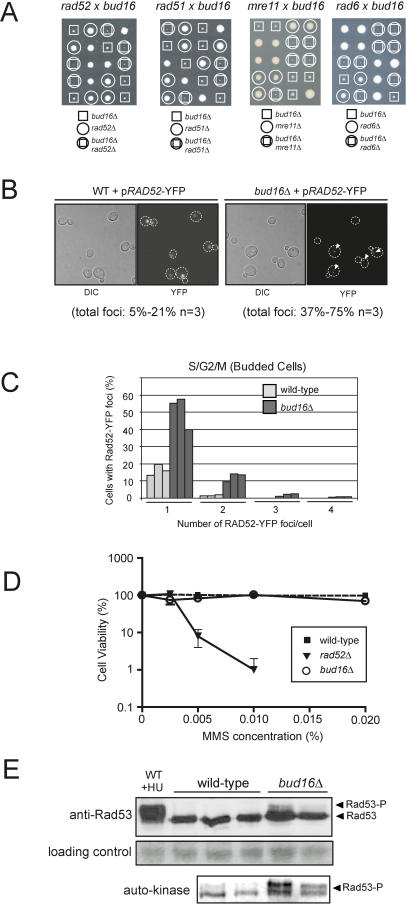
The BUD16 Gene Deletion Causes DNA Lesions and Checkpoint Activation(A) Tetrad analysis of crosses between bud16Δ and rad52Δ, rad51Δ, mre11Δ, or rad6Δ.(B) Micrographs of wild-type (WT) or bud16Δ cells expressing Rad52-YFP. Left panels: differential interference contrast (DIC). Right panels: YFP fluorescence microscopy (YFP). Arrowheads point to Rad52-YFP foci.(C) Quantitation of Rad52-YFP foci per cell. Three independent isolates were examined with over 180 cells per isolate counted.(D) Survival curves of wild-type, bud16Δ or rad52Δ cells serially diluted and plated onto rich media +/− MMS (as indicated) and grown for 3–8 d at 30 °C in triplicate. Percent survival at a given MMS concentration represents the number of colony-forming units of the indicated strain divided by the colony-forming units of the wild type plated on media lacking MMS. No viable rad52Δ colonies were recovered at concentrations above 0.015% MMS.(E) bud16Δ cells engage the DNA damage checkpoint. Upper panel: Rad53 immunoblots of extracts of the indicated strains. Middle panel: Ponceau stain for loading control. Lower panel: Rad53 activity assessed by auto-kinase assays [40]. The immunoblot and auto-kinase assays were performed on the same extracts.